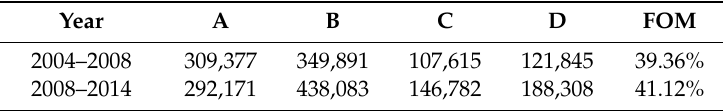
Table 7. The FOM values from 2004 to 2008 and from 2008 to 2014.